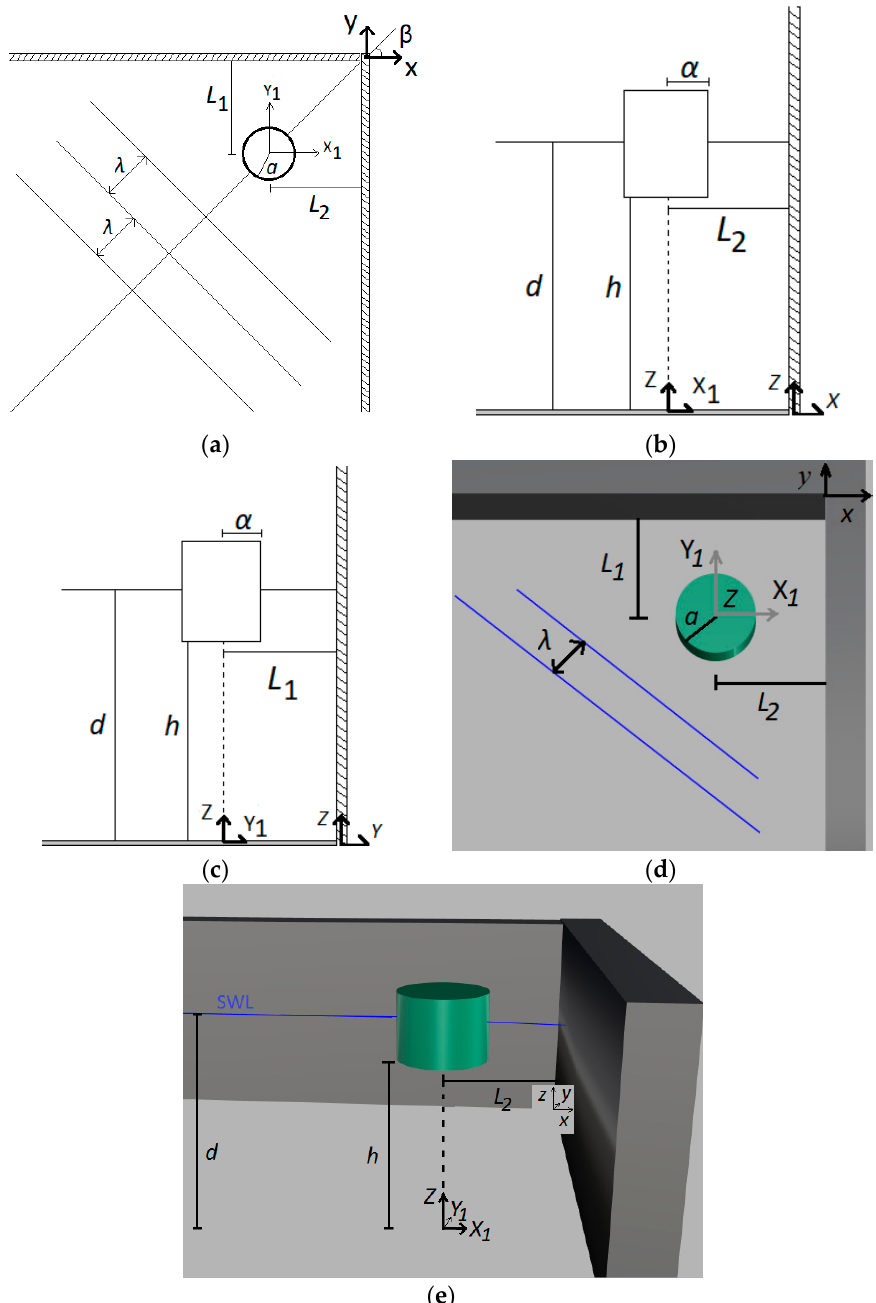
Figure 1. 2-D and 3-D representation of a vertical cylindrical floater in front of an orthogonal breakwater: ( a ) plan view in 2-D; ( b ) side view − xz in 2-D; ( c ) side view − yz in 2-D; ( d ) plan view − xyz in 3-D; ( e ) side view − xzy in 3-D.